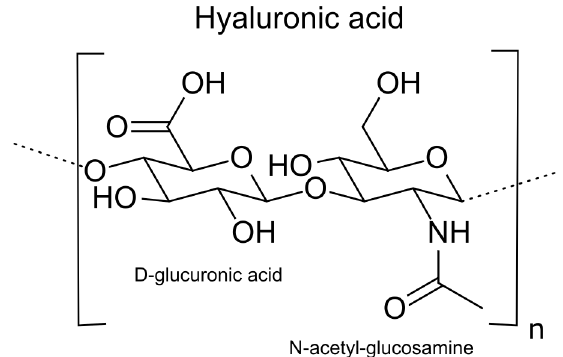
Figure 1. The structural formula of a disaccharide building block of the hyaluronic acid polymer composed of alternating D-glucuronic acid and And-acetyl-d-glucosamine units; n indicates the number of repeating units in a polymer molecule.